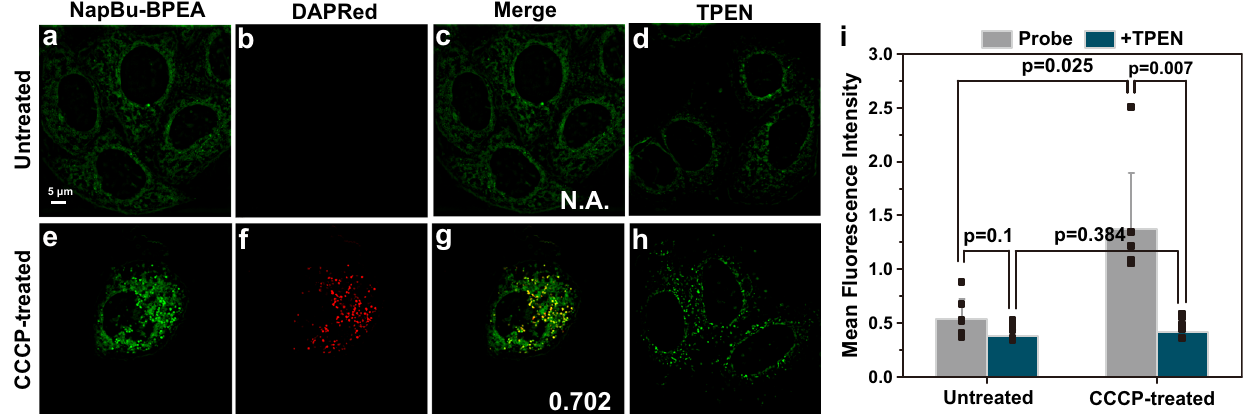
Fig. 5 NapBu-BPEA reveals labile Zn 2 + dynamics in autophagic HeLa cells. SIM images of HeLa cells stained by NapBu – BPEA and DAPRed without ( a – d ) or with ( e – h ) CCCP (10 μ M, 24 h, 37 °C) treatment. a , e cell images from the green channel for NapBu – BPEA (10 μ M, 1 h, 37 °C) fl uorescence; b , f cell images from the red channel for DAPRed (1 μ M, 30 min, 37 °C) fl uorescence; c , g merged images of red and green channel images; ( d , h ) cell images for cells in a , b underwent TPEN (100 μ M, 30 min, 37 °C) treatment; i average fl uorescence intensity recorded in the green channel images for cells with or without CCCP treatment. n = 6 biologically independent experiments per group, mean ± SD, the statistical differences between the experimental groups were analyzed by double-tailed Student ’ s t test, when p < 0.05, it was considered to have statistical signi fi cance. Scale bar, 5 μ m. Source data are available as a Source Data fi autophagy . For the CCCP-incubated HeLa cells, the PCC of the green fl uorescence with the red fl uorescence was ~0.70 (Fig. 5e – g), and the merged image indicated that most of the brighter green fl uorescent dots coincided with the red fl uor- escent dots, con fi rming that NapBu-BPEA accumulated also in autophagosomes and autolysosomes. We therefore used NapBu- BPEA to explore Zn 2 + simultaneously in the mitochondria, autophagosomes/autolysosomes, and ER in HeLa cells upon incubation with CCCP or EBSS (Fig. 6 and Supplementary Fig. 18). We performed confocal imaging at the same time for comparison.